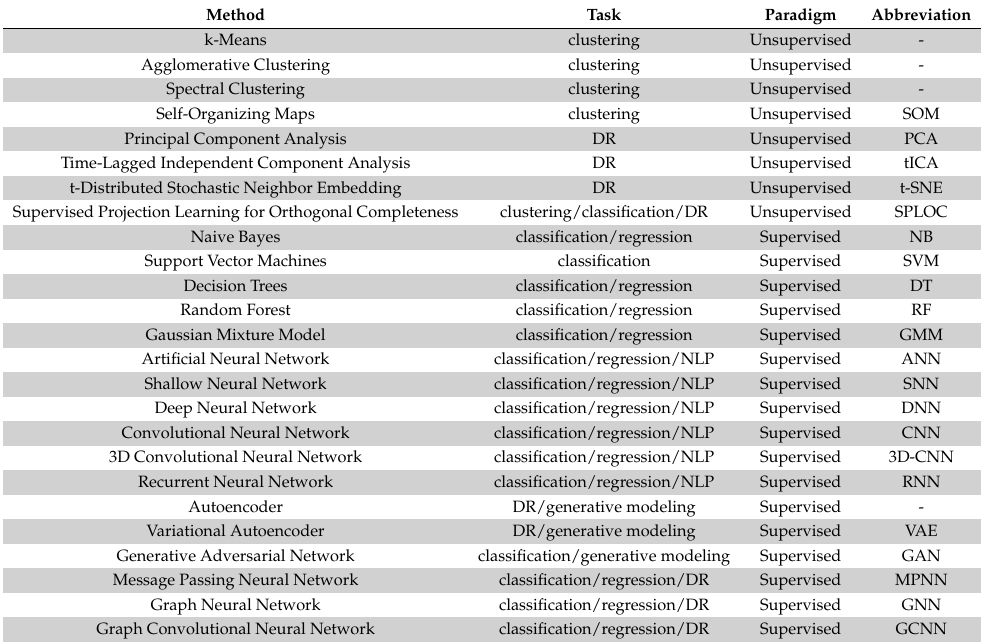
Table 1. Survey of commonly used machine learning models. Abbreviations defined here are used throughout this